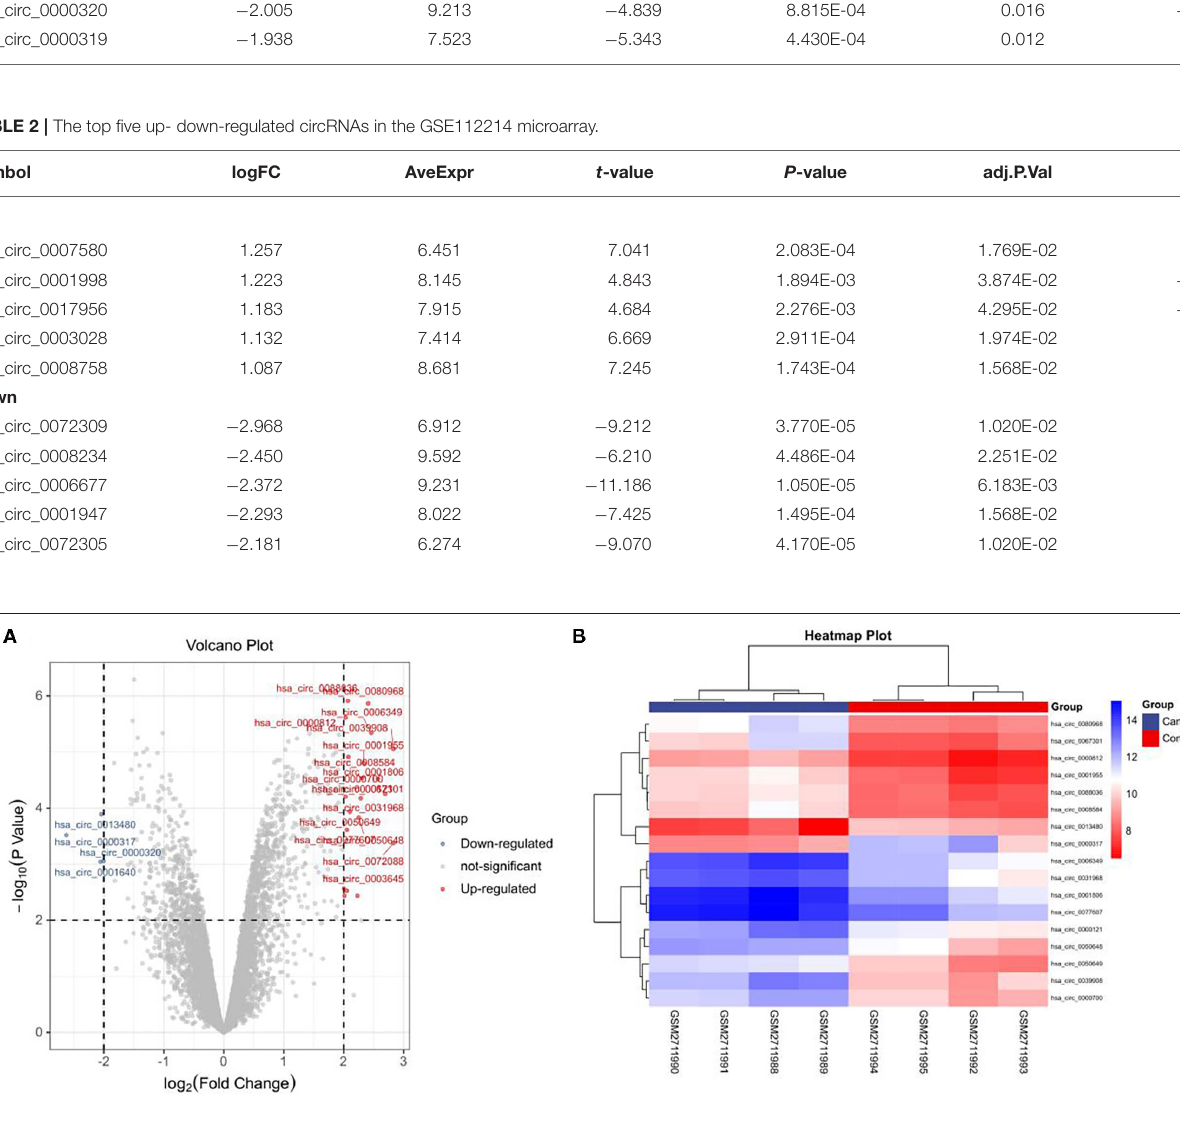
FIGURE 1 | Volcanic plot and heat map of circRNAs with aberrant expression in the GSE101684 microarray. (A) . Volcanic plot of circRNAs with aberrant expression in the GSE101684 microarray: Red, blue and gray represent those with high, low, and undifferential expression, respectively. (B) . Heat map of circRNAs with aberrant expression in the GSE101684